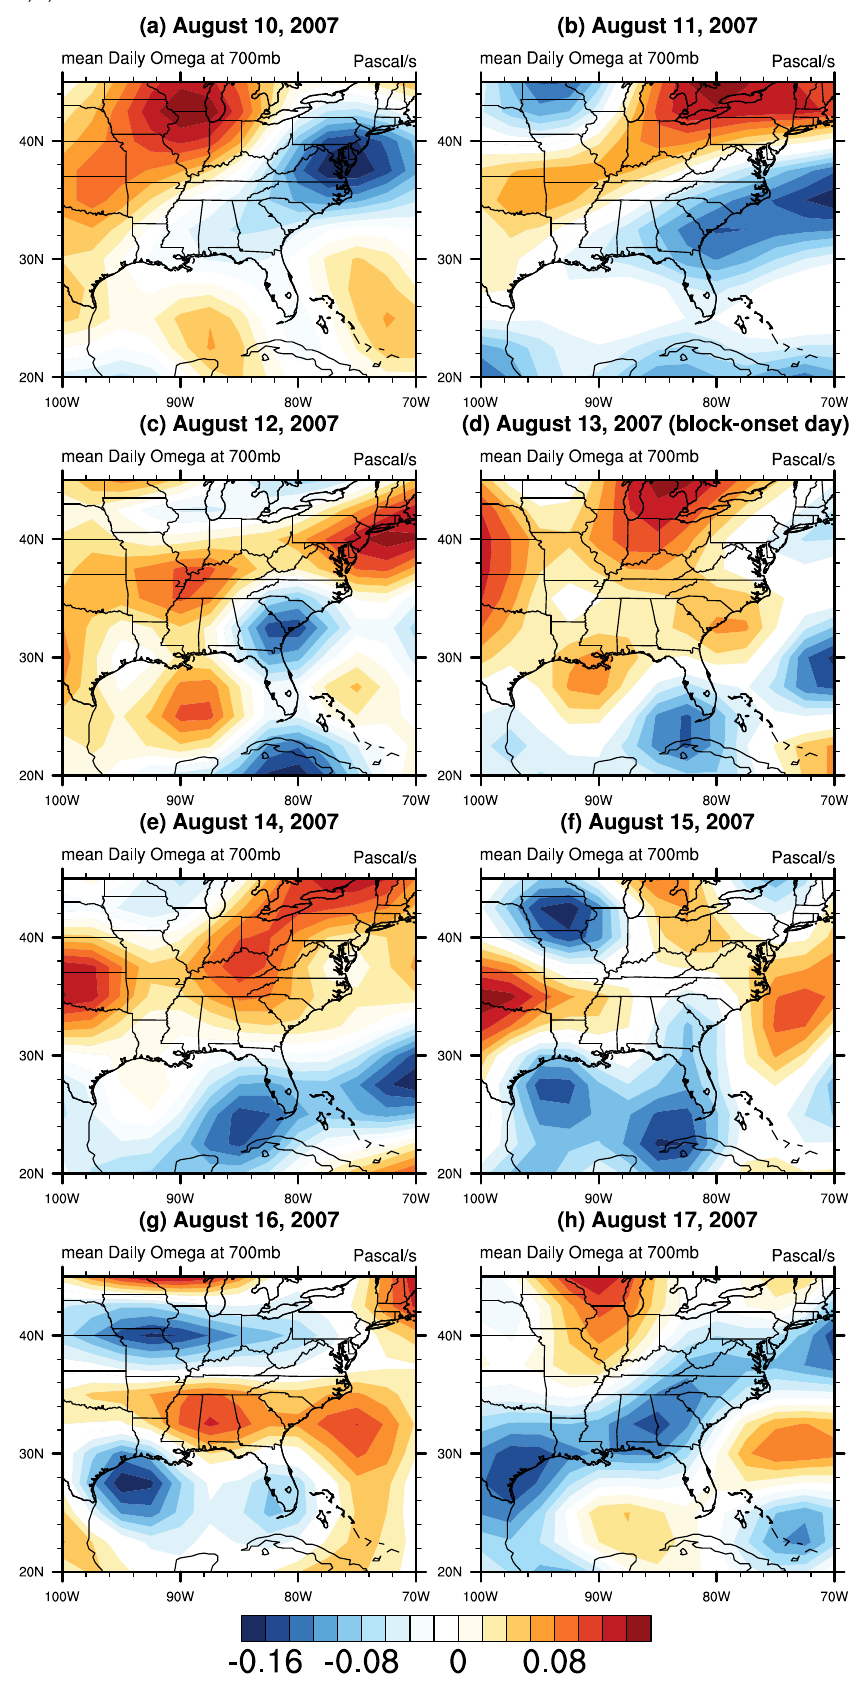
Figure 7. 700-mb vertical motion (omega) from 10 August 2007 ( a ) to 17 August 2007 ( h ), in units of Pa/s, during the evolution of August 2007 blocking